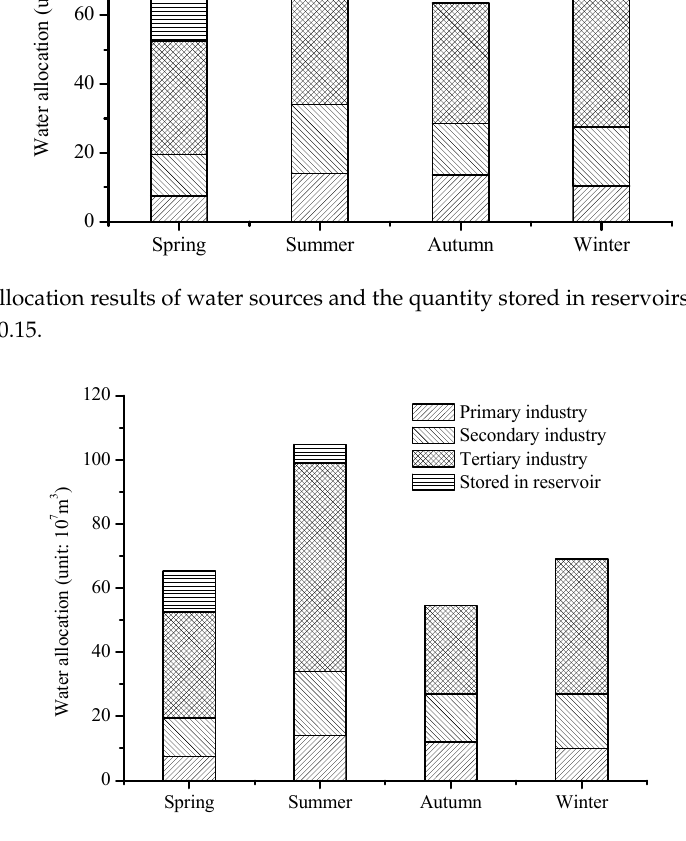
Figure 6. The allocation results of water sources and the quantity stored in reservoirs under violating constraint 0.10 .